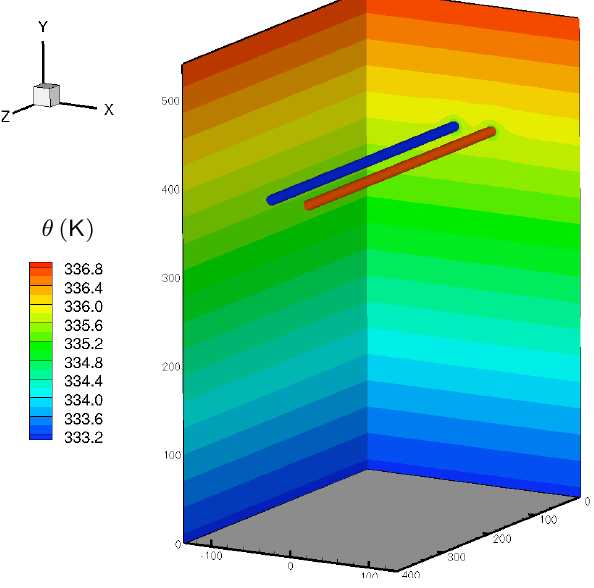
Fig. 1. Initial vortex field and background potential temperature. The red (blue) isosurfaces represent the axial vorticity ω x = 1s − 1 ( ω x =− 1s − 1 ).